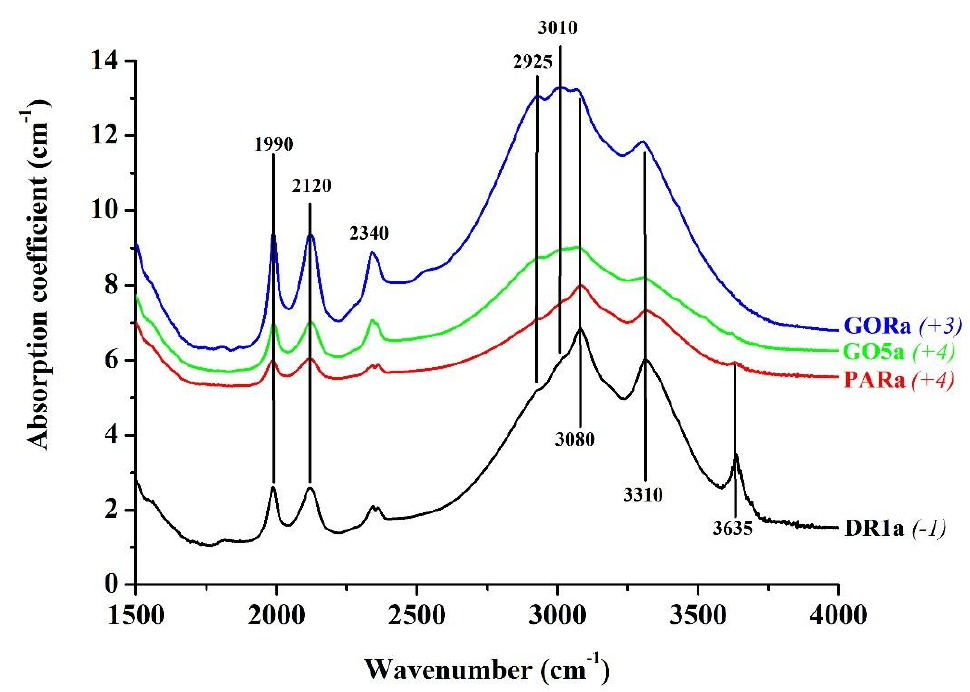
Figure 4. FTIR spectra of the samples DR1a (black trace), PARa (red trace), GO5a (green trace) and GORa (blue trace). All spectra are shifted vertically (value in parenthesis) for clarity.